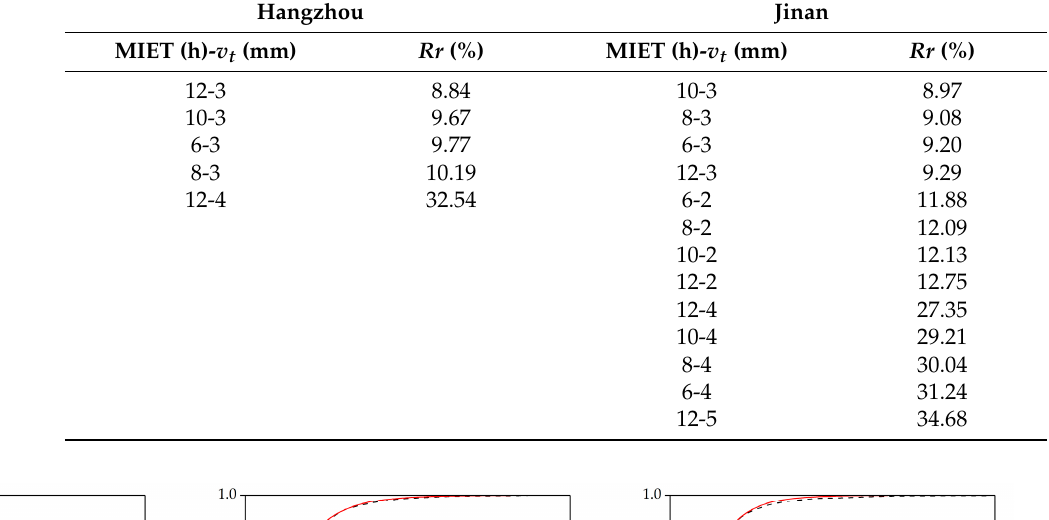
Table 7. The R r results for Hangzhou and Jinan.